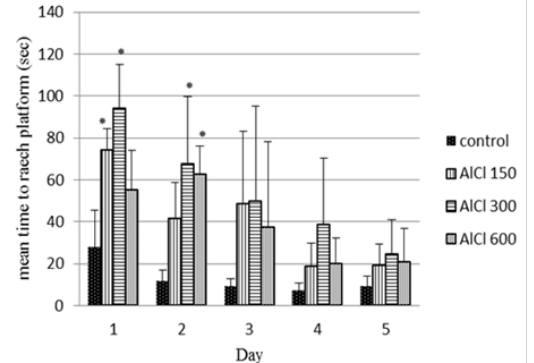
Figure 2 . Hippocampus. Staining with Thioflavin S, Figure 2. Hippocampus. Staining with Thioflavin S, senile senile plaques cannot identify in all the group. A. plaques cannot identify in all the group. A. 100× 100× magification of hippocampus, B. Control magification of hippocampus, B. Control group, group, C. AlCl 150 mg/kg group, D. AlCl 300 C. AlCl 150 mg/kg group, D. AlCl 300 mg/ 3 3 3 3 mg/kg group, E. AlCl 600 mg/kg group. B-E 400× 3 kg group, E. AlCl3 600 mg/kg group. B-E 400× magnification.